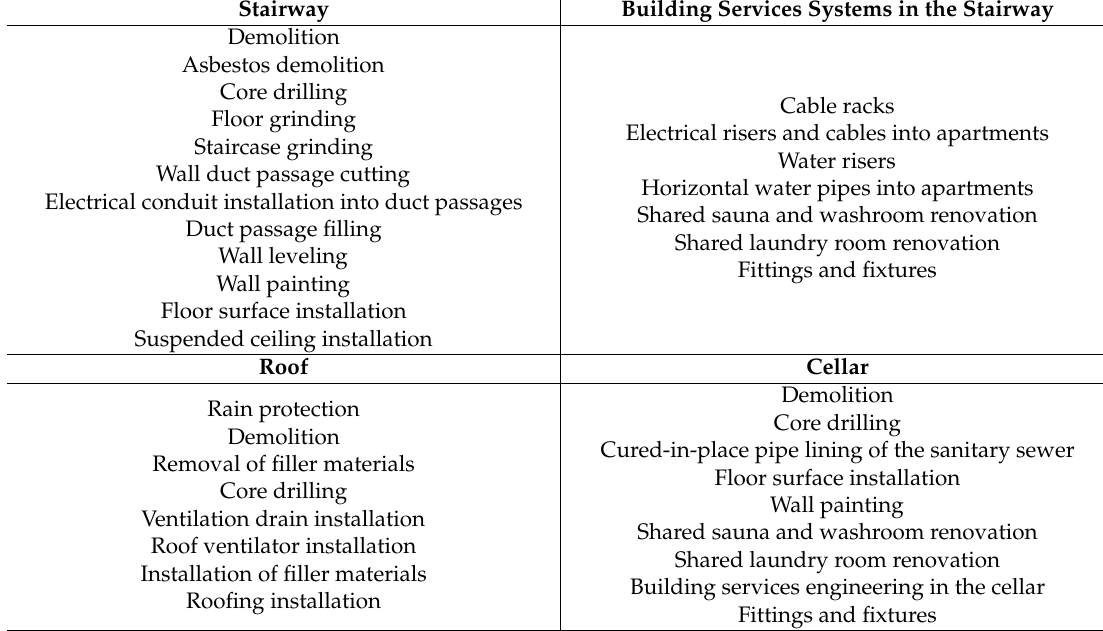
Table 2. Non-takt work and work done outside of the apartments on the case site.